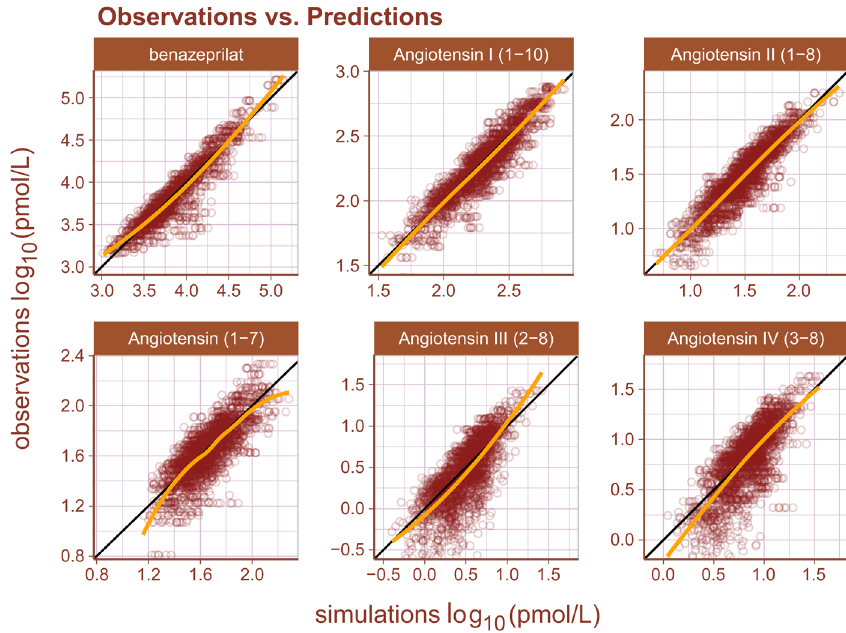
Figure 4. Observations vs predictions. The observations plotted against the predictions for all metabolites and drug concentration data. This gives a complete picture of model performance. The golden line is the LOESS curve showing the correlation between observations and predictions. The black line plotted diagonally represents an ideal model performance with no misspecification. The general agreement between LOESS and idealized curve indicates that there is little misspecification in model structure.